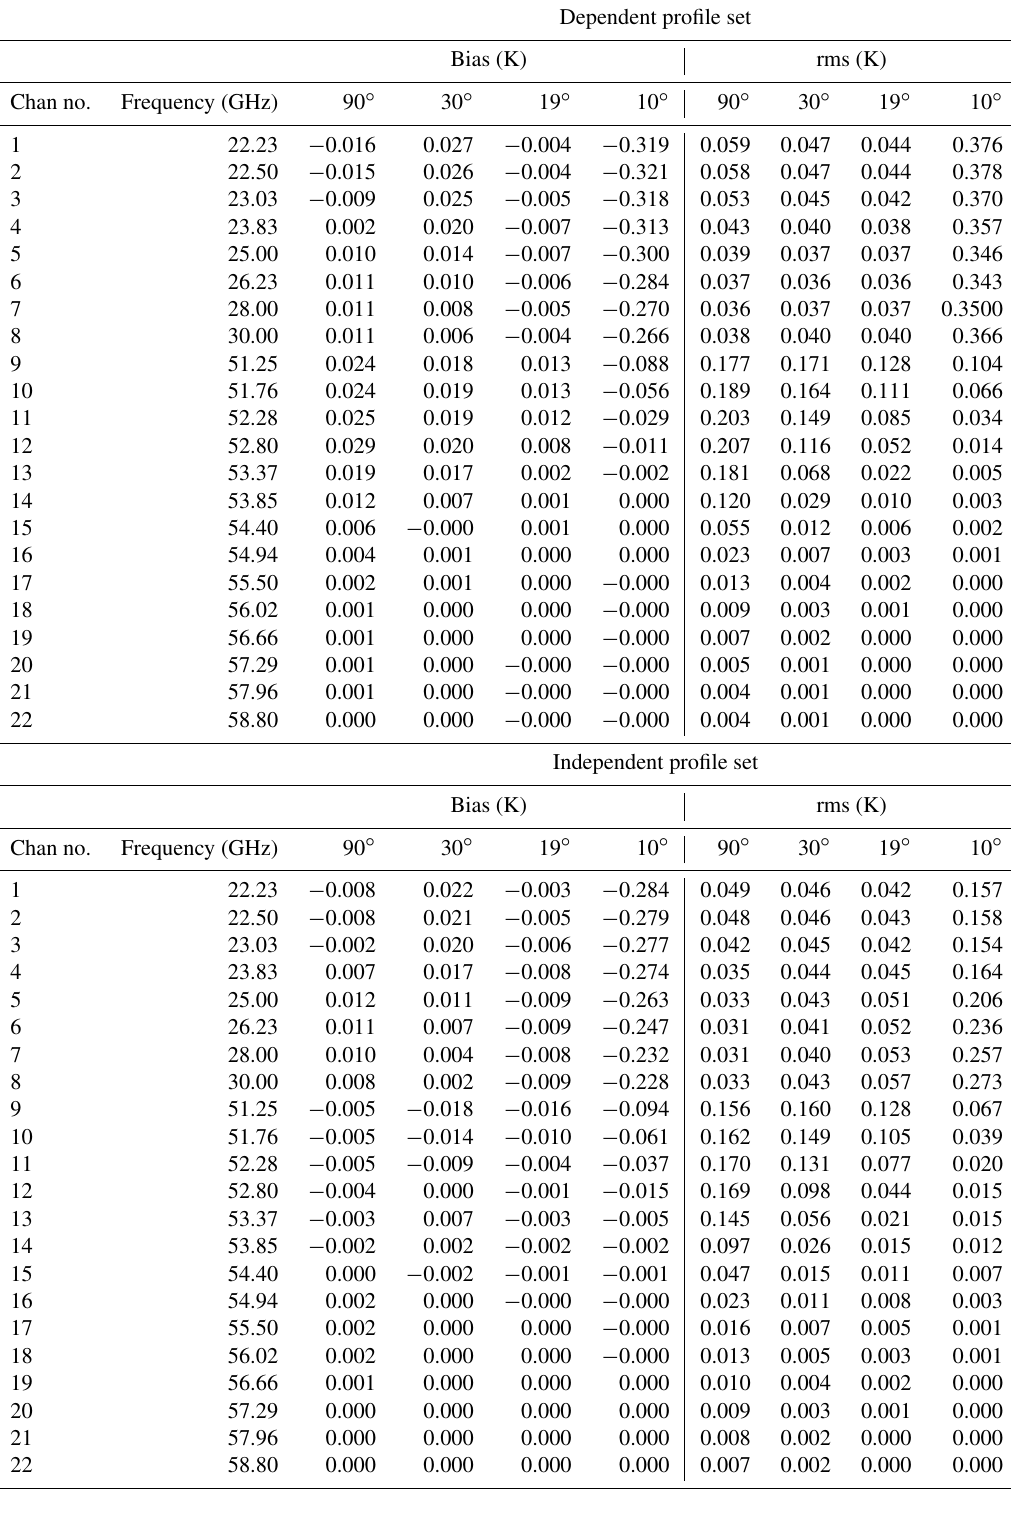
Table 3. Statistics for the comparison between RTTOV-gb and the line-by-line model R98 at MP-3000A channels with the best RTTOV training configuration, for both the dependent (top) and independent (bottom) profile set (R98 minus RTTOV-gb). MP3000A channel number (Chan no.), the channel central frequency, bias, and rms at elevation angles 90, 30, 19, and 10 ◦ are